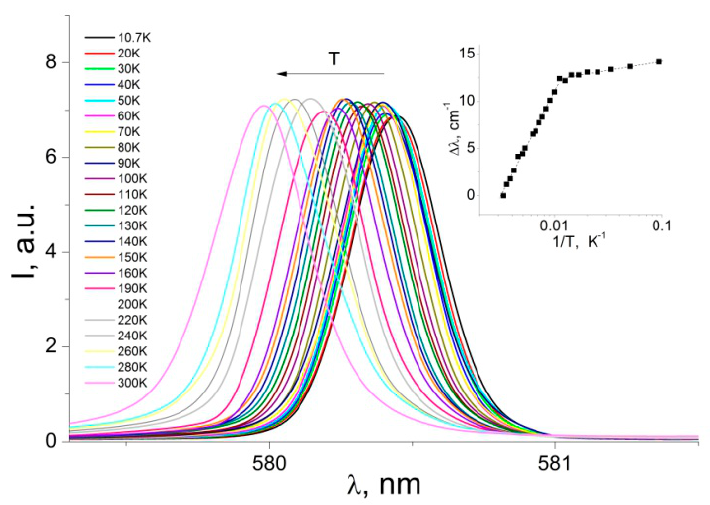
Figure 4. Low-resolution emission spectra for the 5 D 0 → 7 F 0 transition at different temperatures, 10.7–300 K, λ exc = 405 nm.